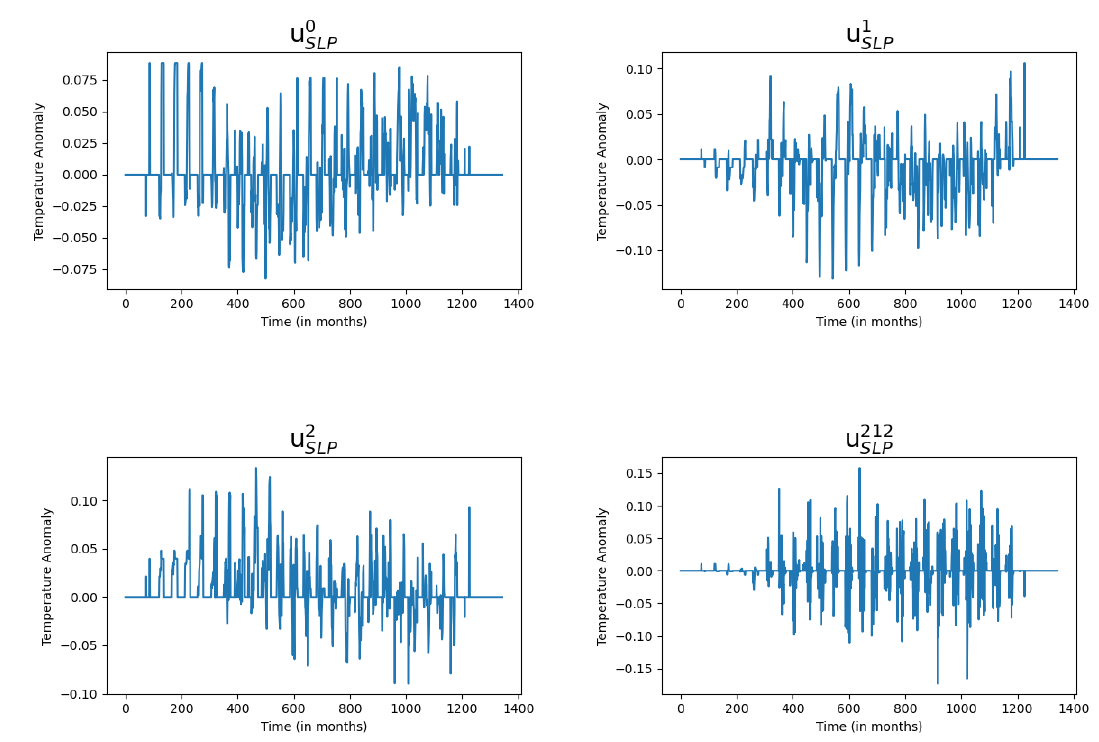
Γ , u 1 , u 2 and u 212 for SLP . x-axis is the index value and y-axis is the amplitude. SLP SLP SLP SLP